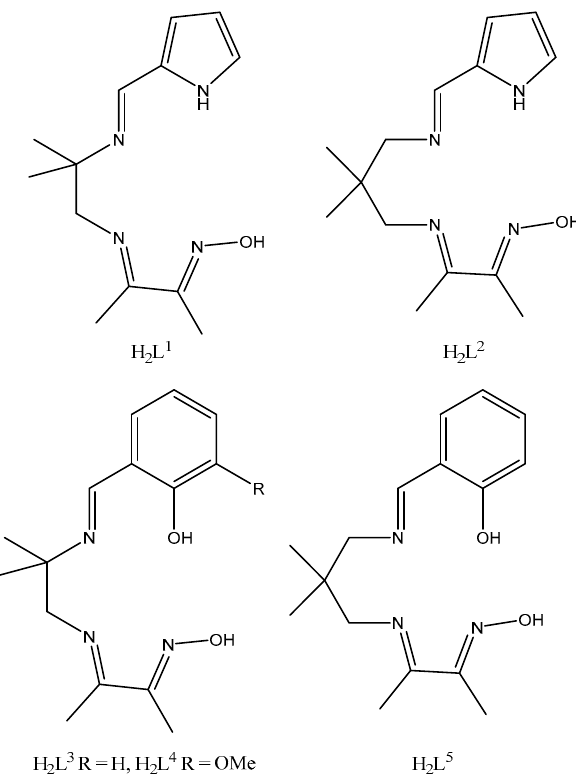
Scheme 2. Ligands used in this